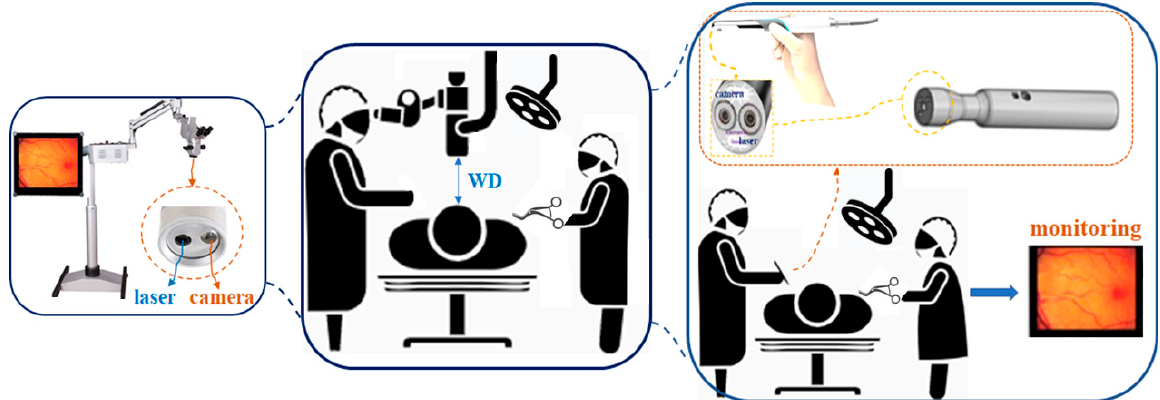
Figure 1. Structure of the conventional surgical microscope and the proposed pen-type probe.